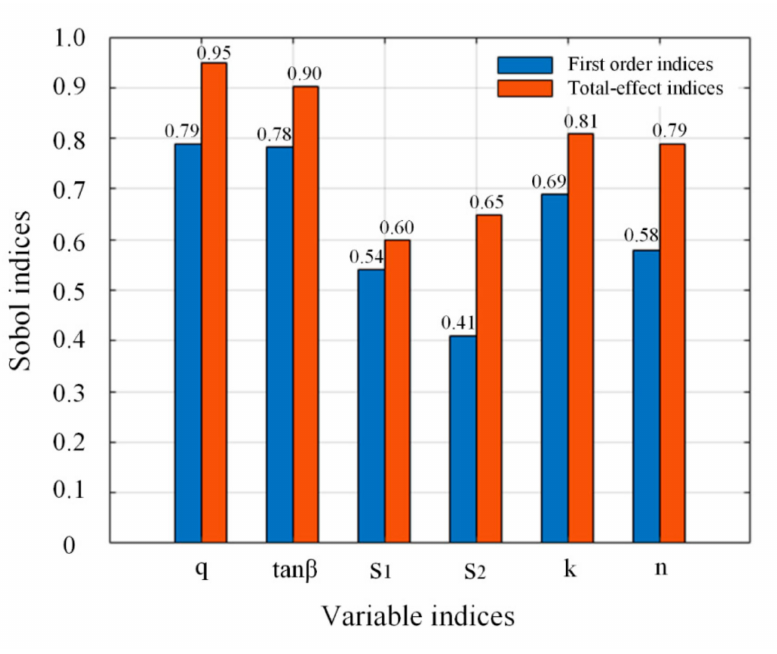
Figure 18. Estimated Sobol indices for CT-PIM